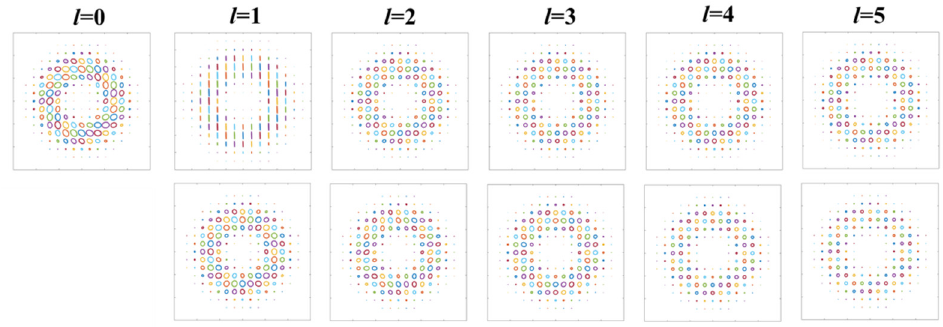
Figure 7. The polarization distribution of the OAM mode in the terahertz OAM PCF.